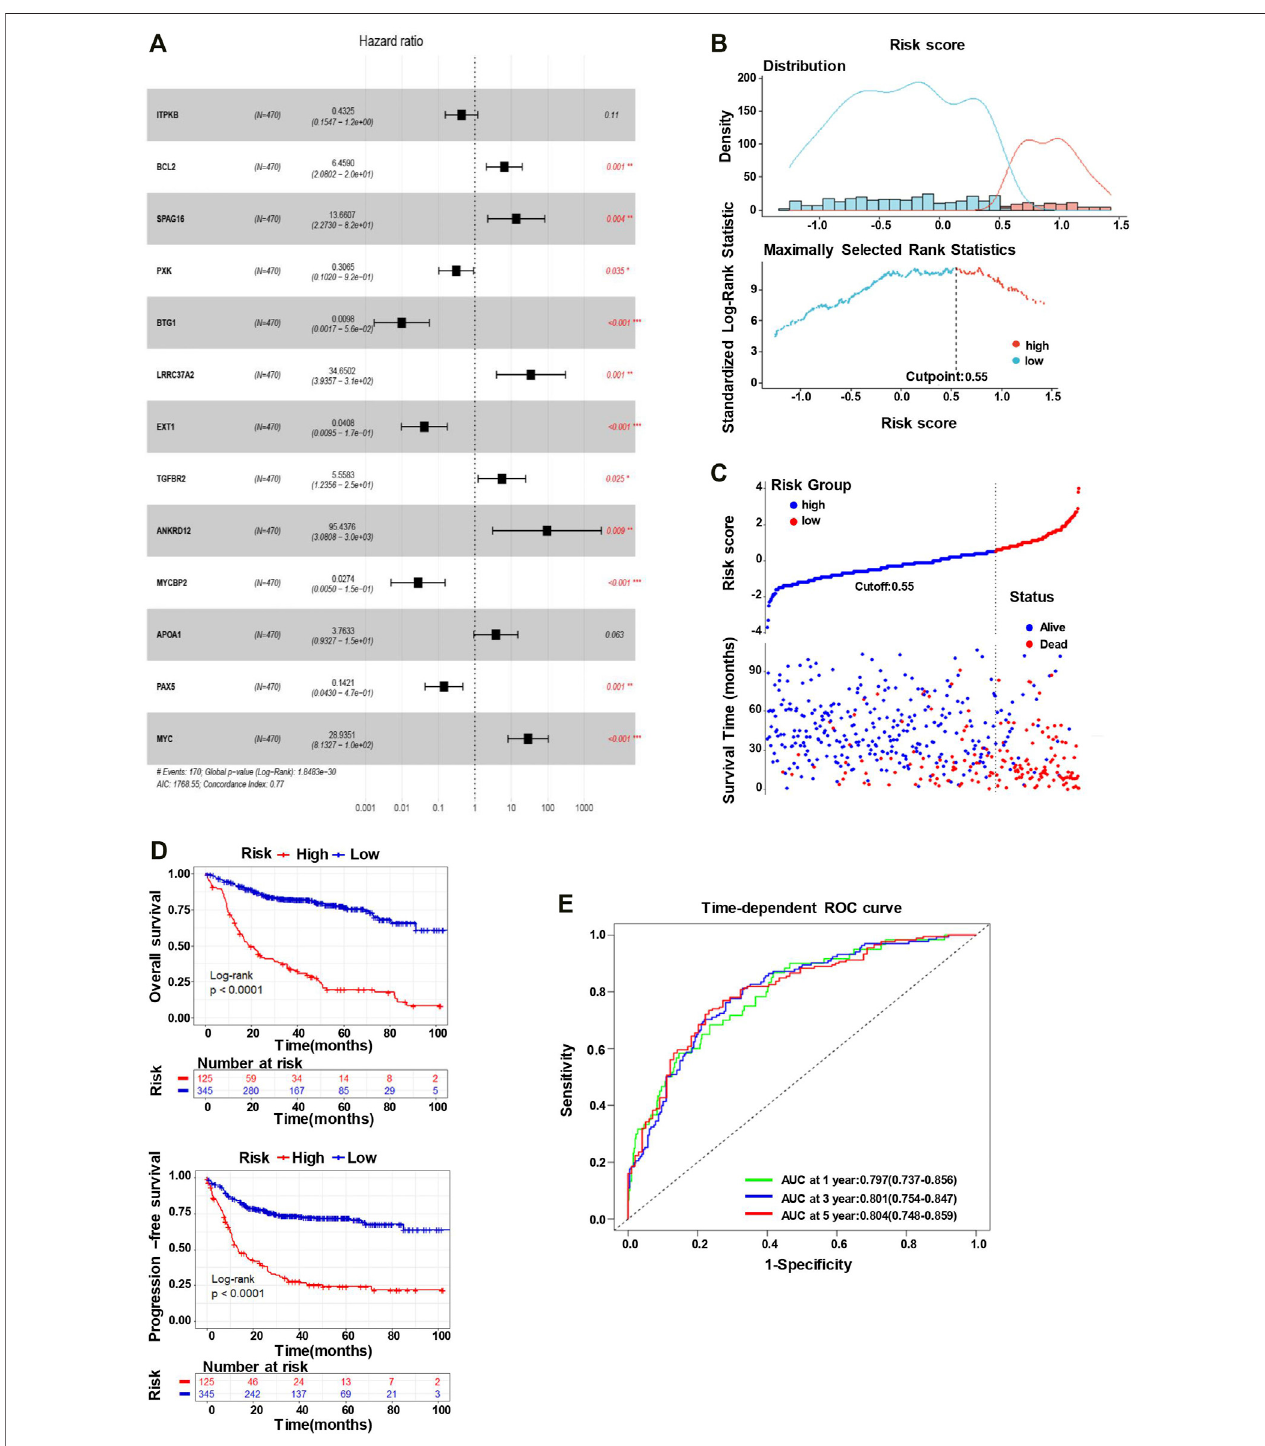
FIGURE 3 | The 11-gene risk score model for the GSE31312 dataset. (A) Multivariate Cox regression analysis of the 13 genes (* p < 0.05, ** p < 0.01, and *** p < 0.001). Hazard ratio and 95% CI are shown in the fi gure. Global log-rank p , C-index, and AIC were also calculated and shown. (B) The identi fi cation of the cutoff value (cutpoint=0.55) of the risk score. (C) DLBCL patients were divided into the high-risk group and low-risk group based on the cutoff value (upper). The survival status and time in high-risk and low-risk groups (lower). (D) Kaplan – Meier survival curves showing the difference in OS (upper) and PFS (lower) between high- and low-risk patients (log-rank test, p < 0.0001). (E) Time-dependent ROC curves for the 11-gene model to predict patient survival.